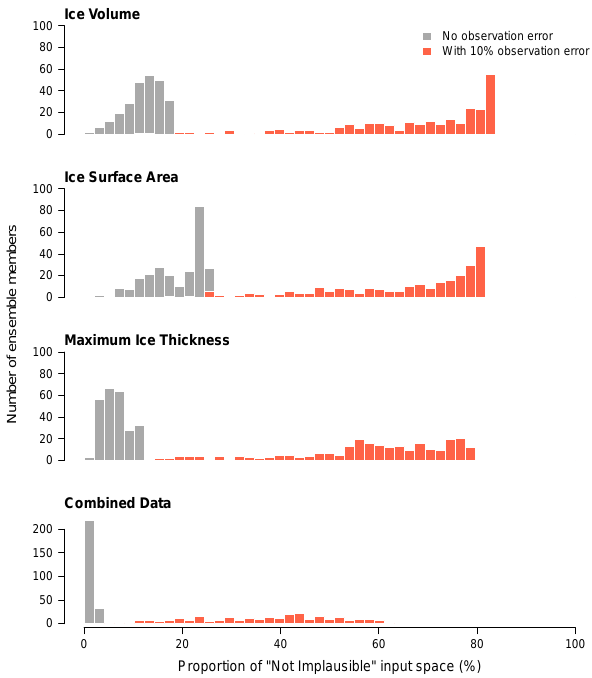
Fig. 8. Histograms of V , the estimated volume of “not implausible” ( I < 3) input space, for each of the 250 members of the ensemble. The case with no observational error (grey bars) shows a much stronger potential constraint than when a representative observational uncertainty of 10 % of the maximum value of the ensemble is included (red bars).